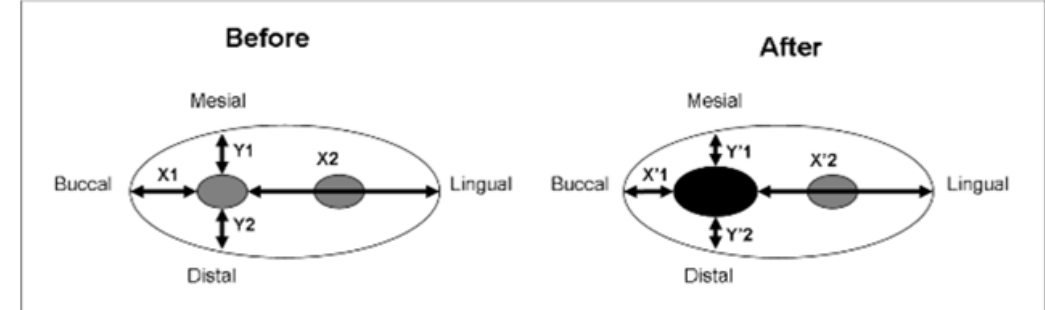
Fig. 2. Schematic presentation of the image used in the evaluation.